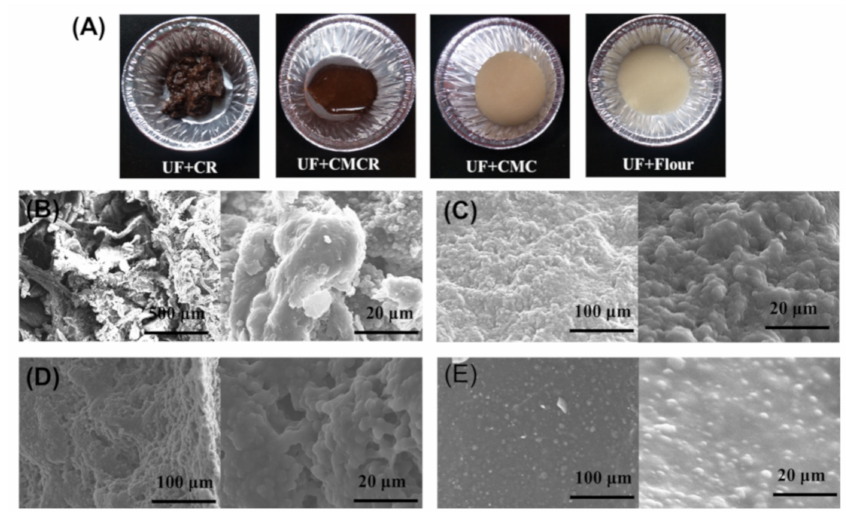
Figure 7. ( A ) Photographs of uncured UF resin with di ff erent fillers. Fracture SEM of the cured resins: ( B ) UF + CR; ( C ) UF + CMCR; ( D ) UF + CMC; and ( E ) UF + Flour.